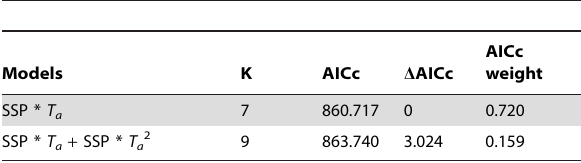
Table 3. Linear mixed models describing surface temperature of the bill base ( T base